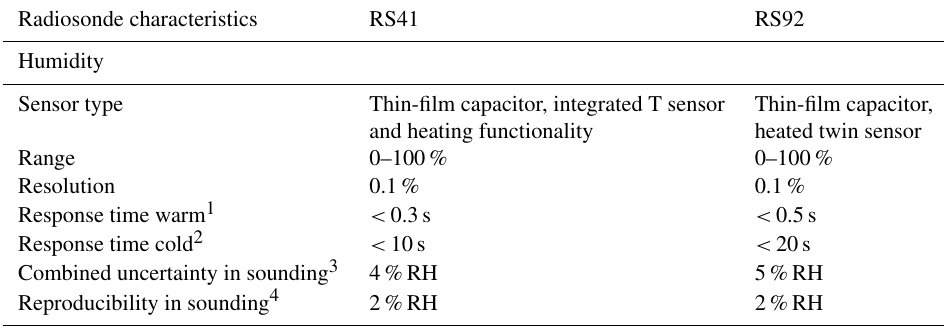
Table 3. Radiosonde humidity sensor manufacturer specifications (based on Table 4 from Jauhiainen et al., 2014). Radiosonde characteristics